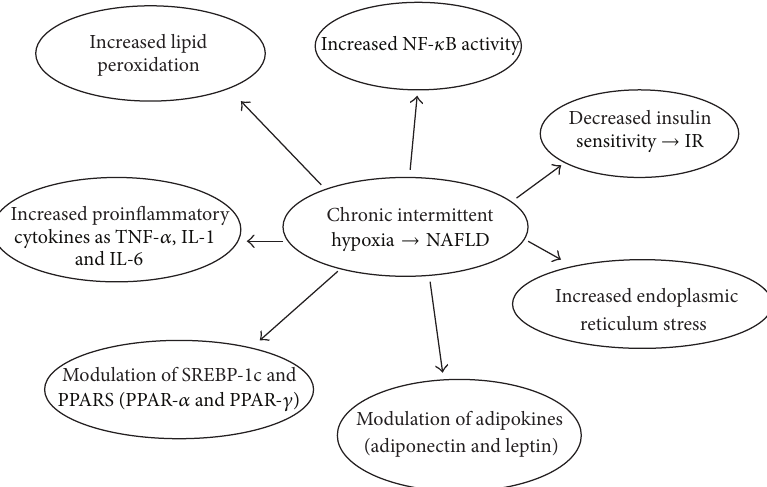
Figure 1: The relationship between nonalcoholic fatty liver disease (NAFLD) and chronic intermittent hypoxia (CIH). TNF: tumor necrosis factor. IL: interleukine. SREBP-1c: sterol-regulatory-element-binding protein-1c. PPAR: peroxisome proliferator-activated receptor. ER: endoplasmic